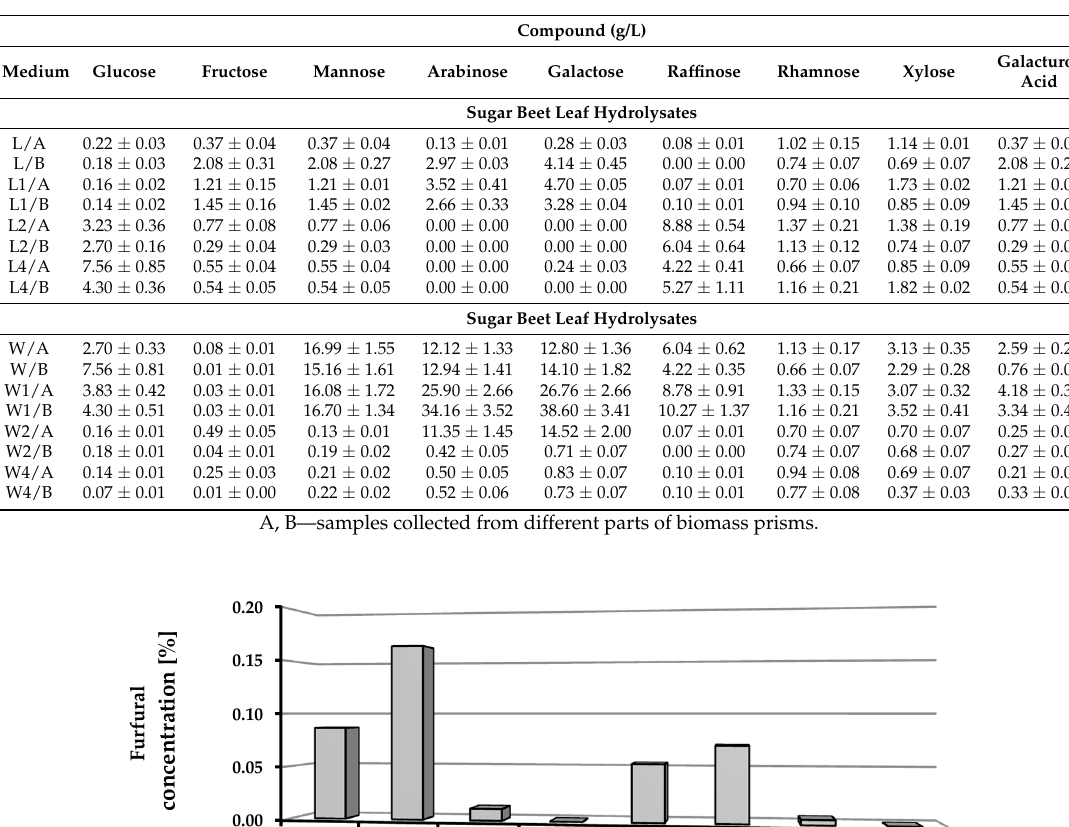
Table 4. Carbohydrate profiles of obtained biomass hydrolysates.